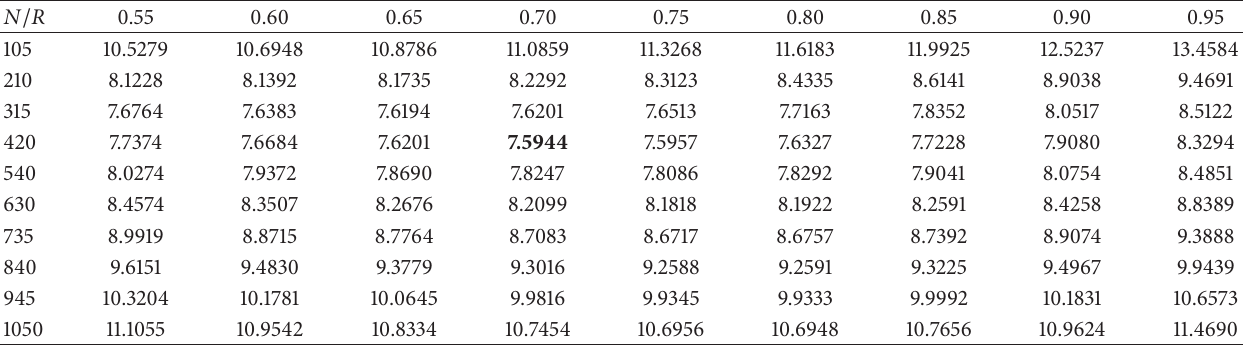
Table 3: Some results obtained from proposed policy.